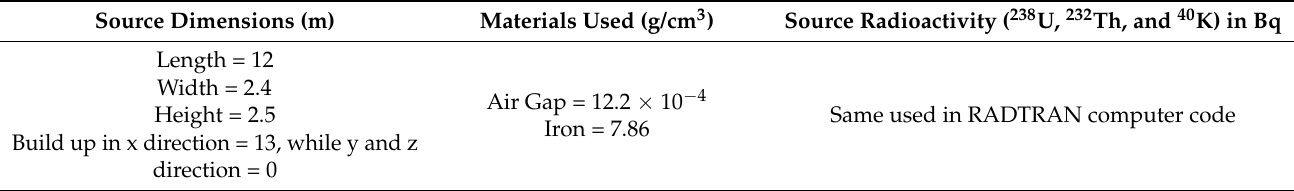
Table 6. Radiological and physical input data used in MicroShield computer code for calculation of dose rate from the shipment.